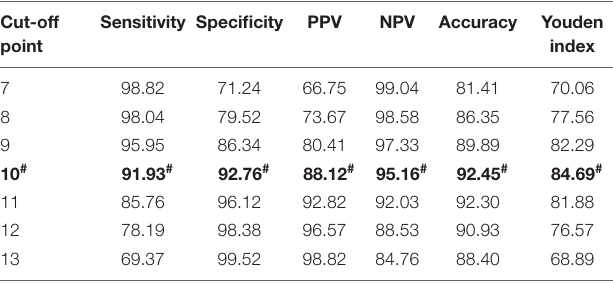
TABLE 5 | Criterion values and coordinates of ROC Curve for